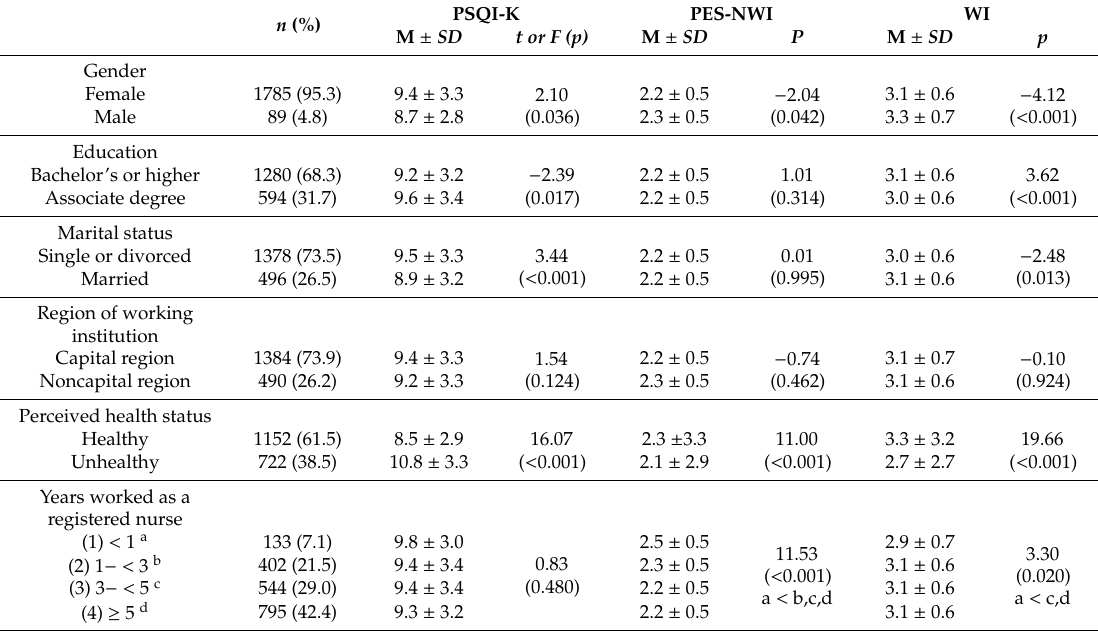
Table 1. Sleep quality, nursing practice environment, and wellness by participants’ characteristics (N =